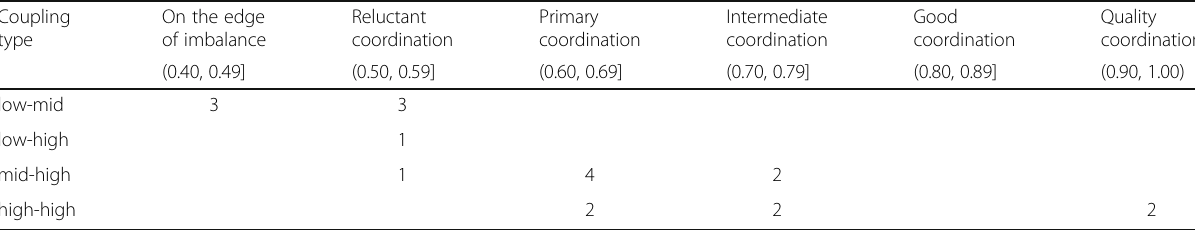
Table 8 Number of coupling types of high population density rail transit stations Coupling